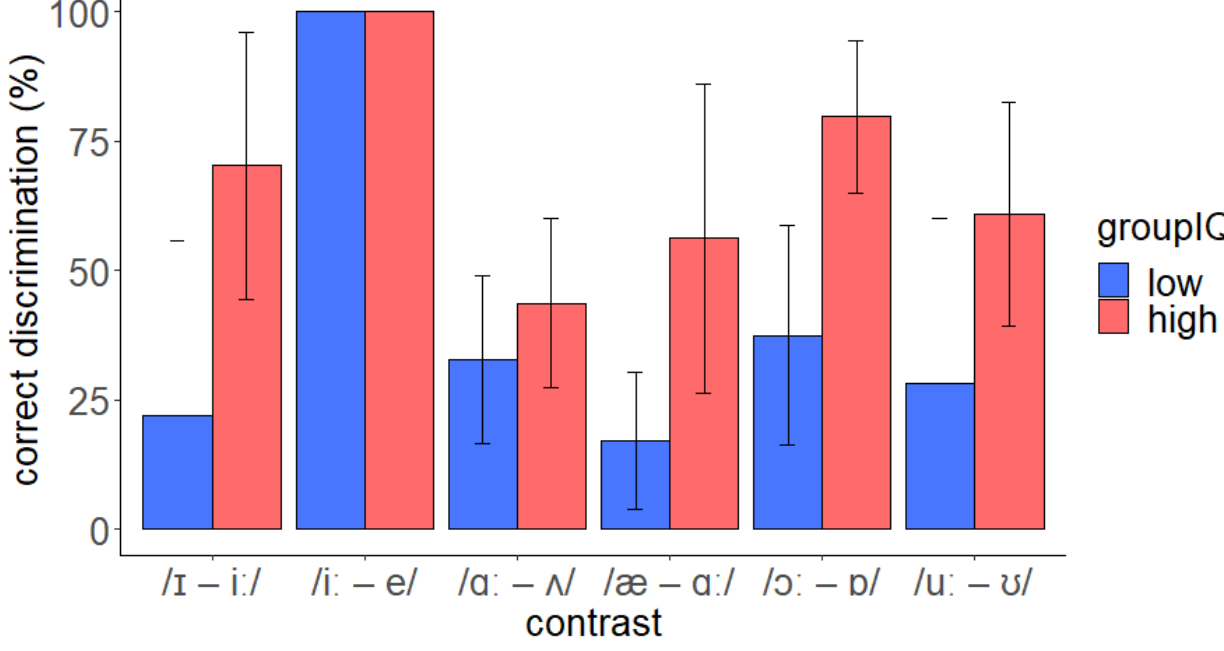
Figure 1. Discrimination of the English vowel contrasts by the low and the high IQ groups.